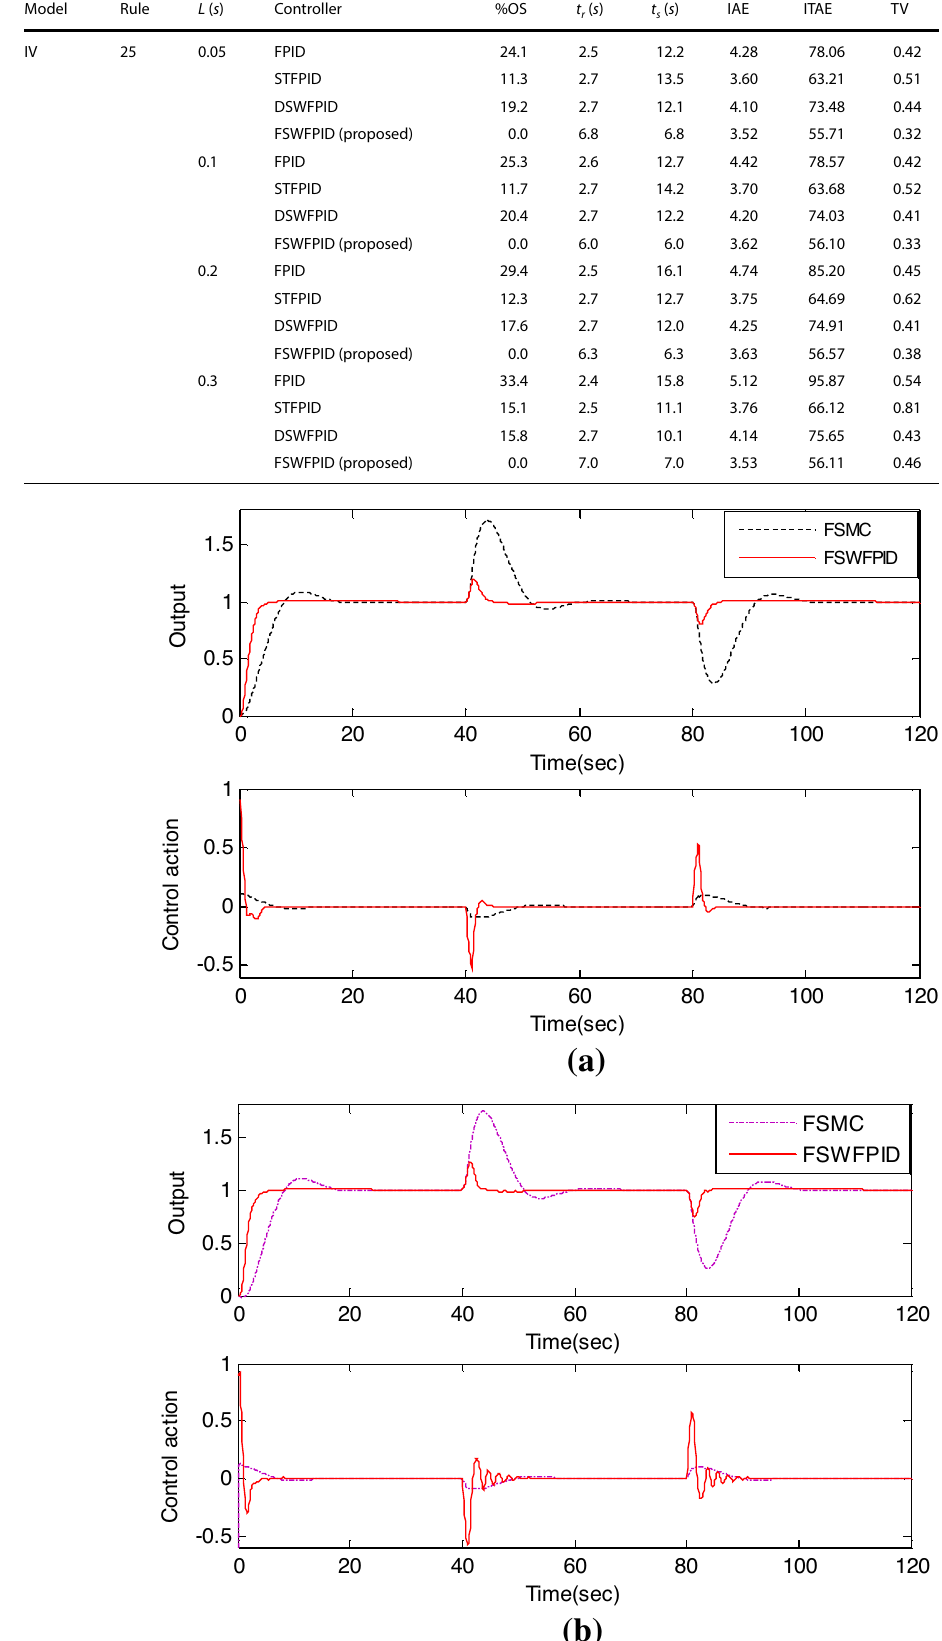
Fig. 18 Comparison among responses and control actions for Model IV with FSMC using 49 rules during set point response and with load varia- tion for a L = 0.1 s, b L = 0.3